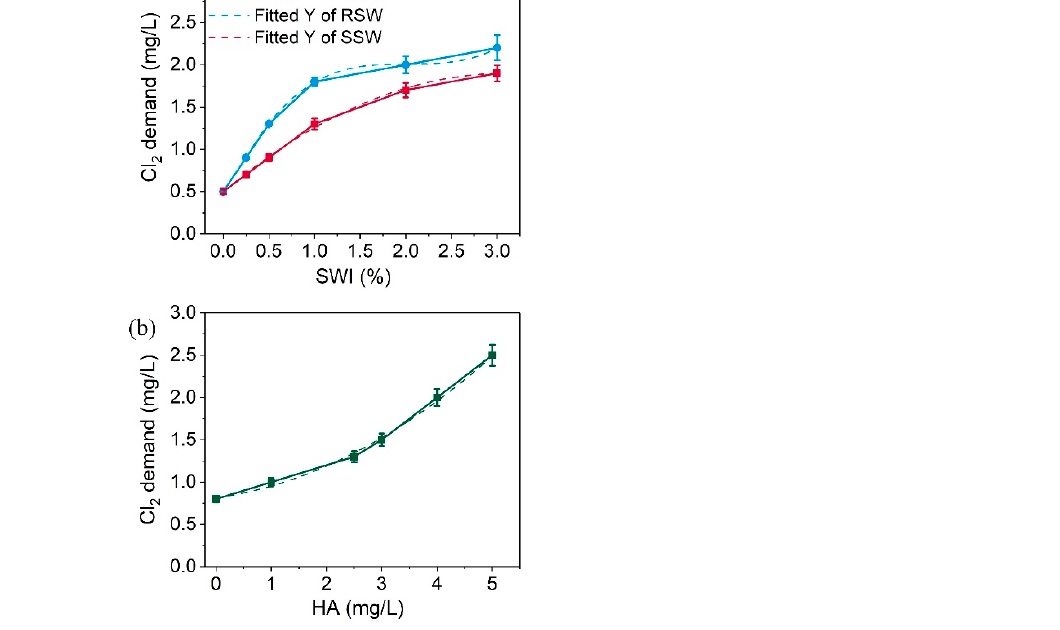
Figure 1. Chlorine demand at various levels of ( a ) seawater intrusion (SWI) with constant humic acid (HA = 2.5 mg/L) concentration and ( b ) HA concentration with constant SWI (SWI = 1%).